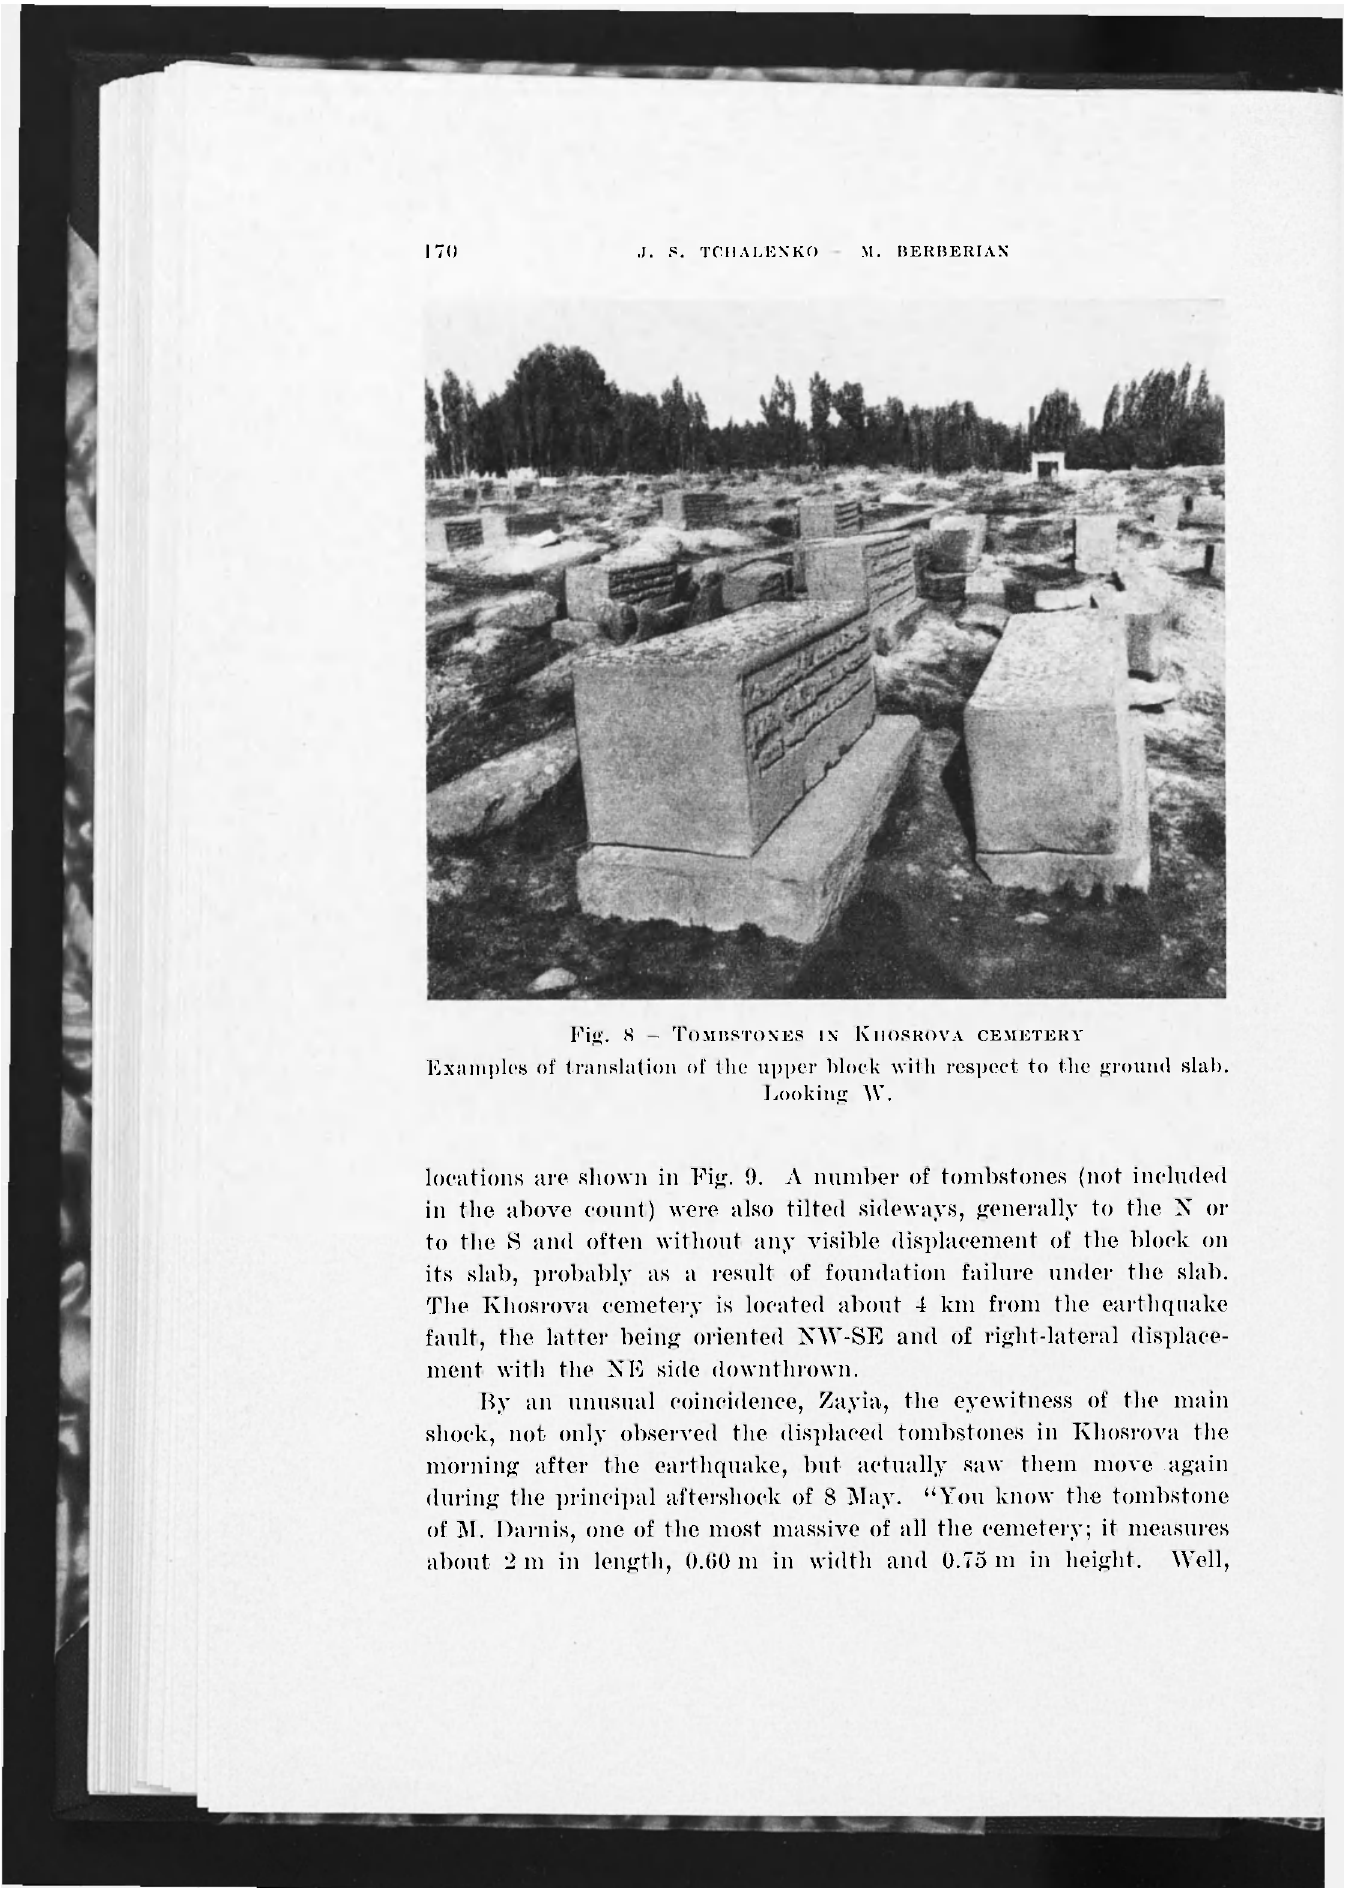
Fig. 8 - TOMBSTONES IN KHOSROVA CEMETERY Examples of translation of the upper block with respect to the ground slab. Looking